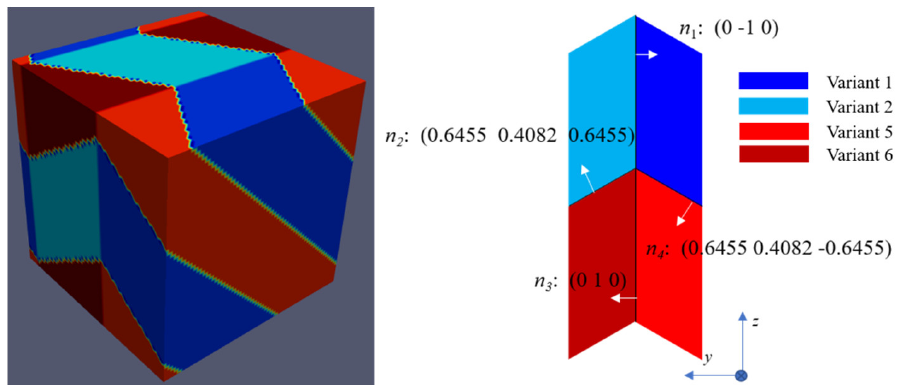
Figure 5. Crossing twinned microstructure with variants 1/2/5/6 and their corresponding shear vectors in the interfacial